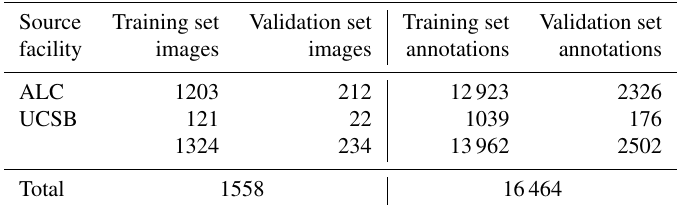
Table 1. A summary of the “czd_large” dataset used to train the deep learning model presented in this paper for reflected-light mineral grain segmentation. Please refer to Sitar (2022b) for more in-depth information on the composition of the